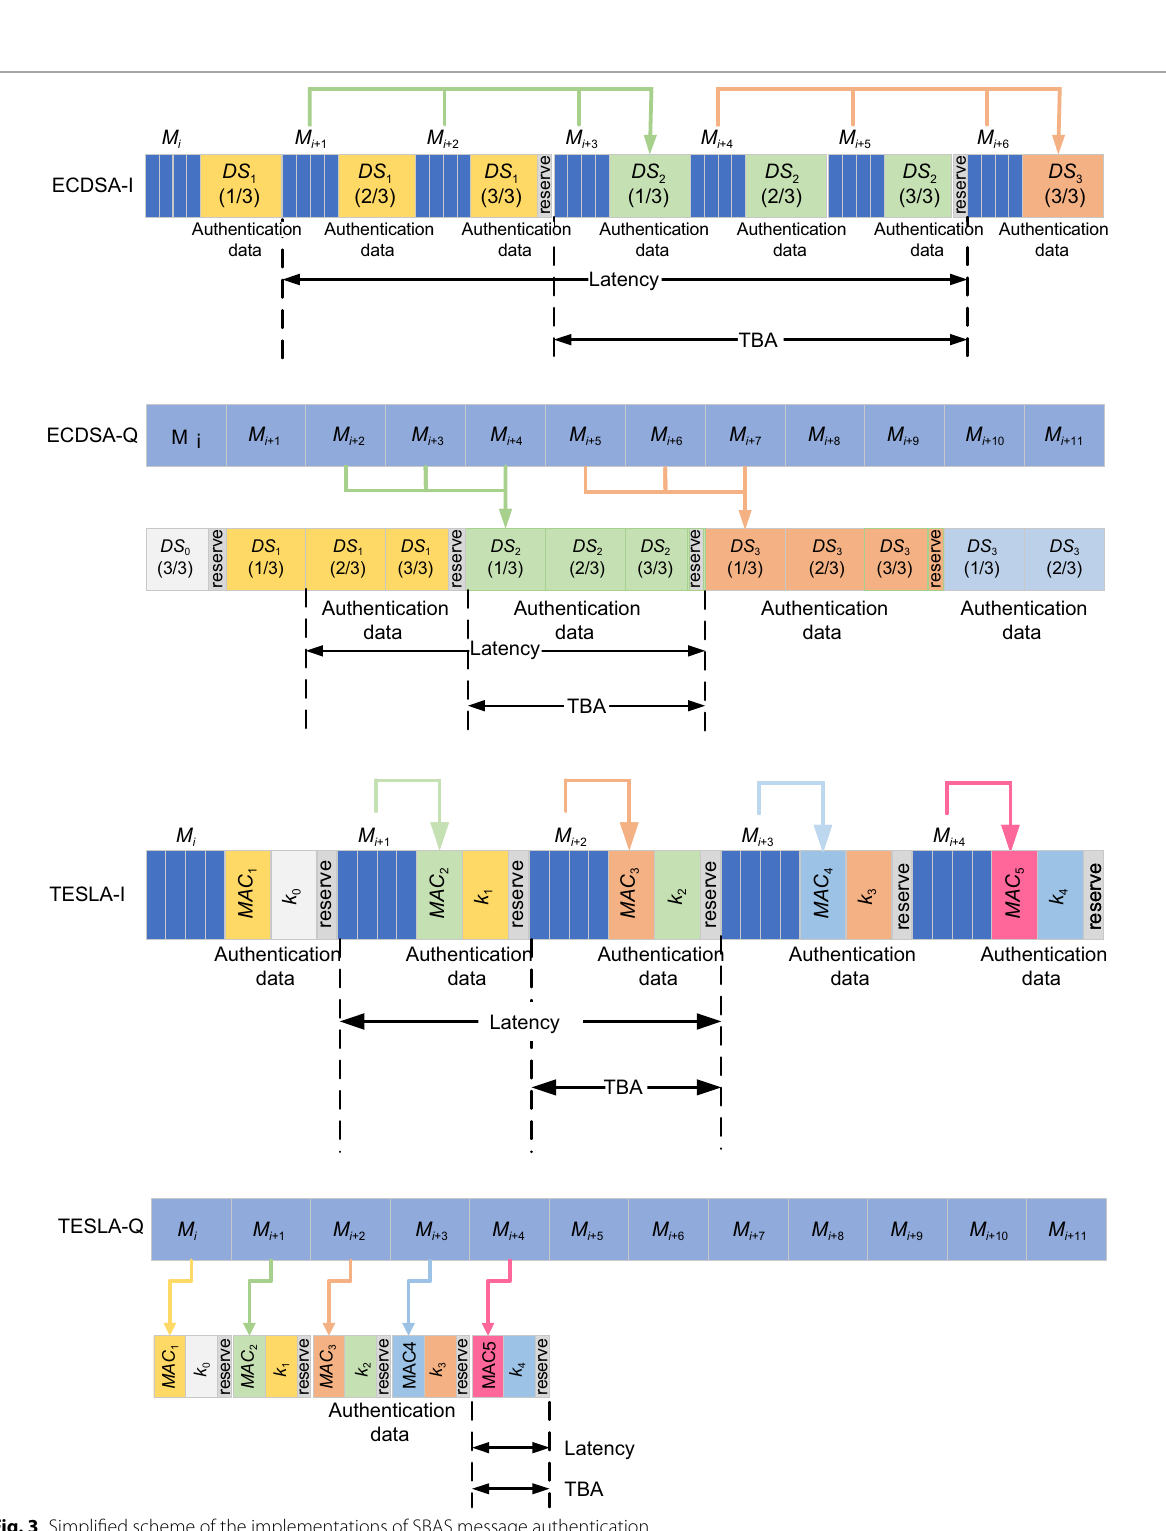
Fig. 3 Simplified scheme of the implementations of SBAS message